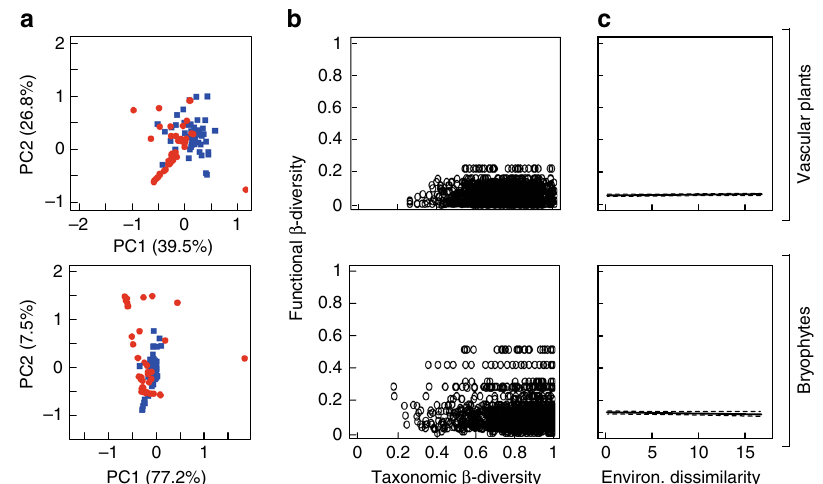
Fig. 4 Functional community composition and functional turnover. a Functional community composition of the two co-response clusters (blue squares = cluster I, red circles = cluster II). Principal component analysis of cluster-weighted means of the fi ve quantitative vascular plant traits and eight bryophyte traits (see Supplementary Fig. 4 for a list of traits, and their cluster-weighted means). b Relationship between taxonomic and functional turnover of the vascular plant (top) and bryophyte (bottom) communities. c Relationship between environmental dissimilarity and functional turnover (vascular plants: F 1,3078 = 1.3, r 2 = 0.02, P = 0.23; bryophytes: F 1,3078 = 1.4, r 2 = 0.02, P = 0.26; Generalized Linear